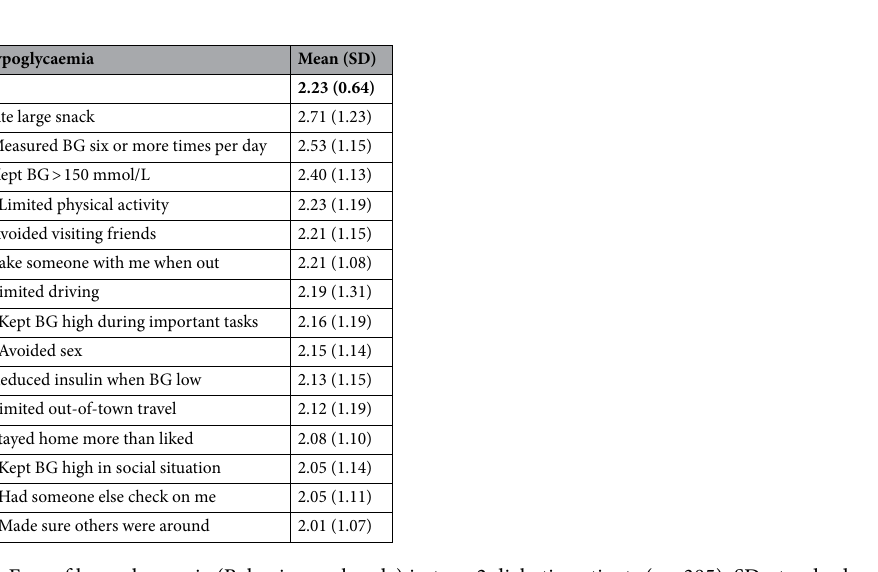
Table 3. Fear of hypoglycaemia (Behaviour subscale) in type 2 diabetic patients ( n = 385). SD, standard deviation; HFS-B, behaviour subscale of hypoglycaemia fear survey; BG, blood glucose.